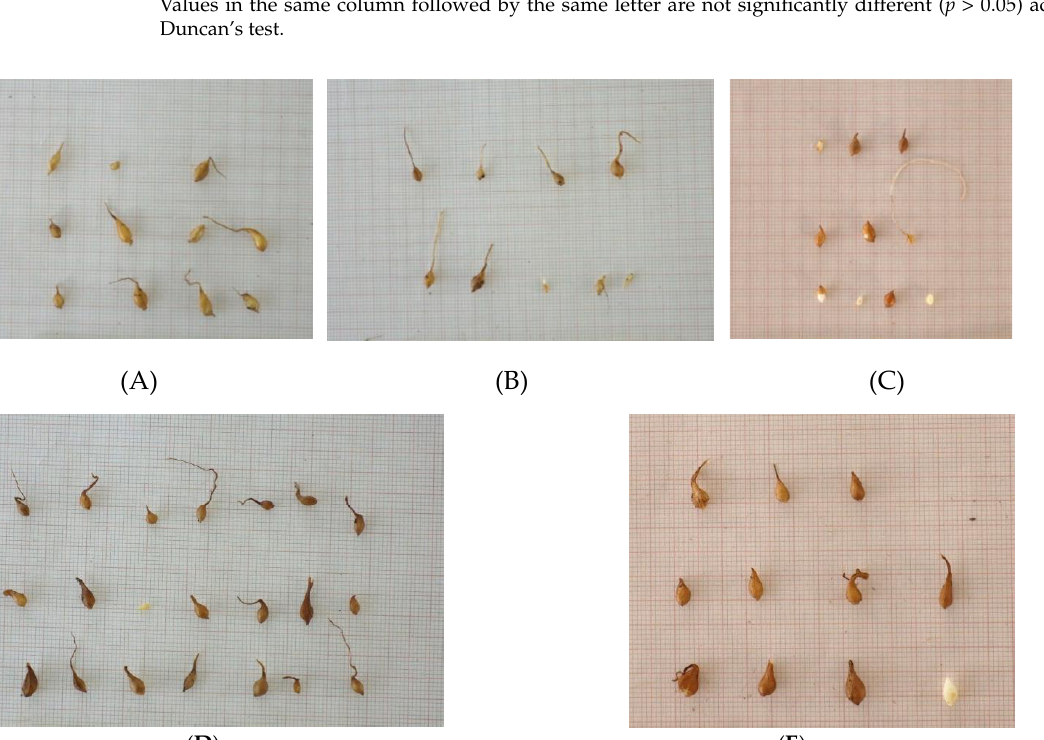
Table 1. Weight, length, and width of Tulipa australis , T. bakeri , T. clusiana , T. goulimyi , and T. un- dulatifolia bulblets at the end of the first growing period. Mean ± standard deviation values are provided. Bulblet Weight Bulblet Length Bulblet Width Species (mg) (cm) (cm) Tulipa australis 25.26 ± 3.76 a 0.2455 ± 0.021 a 0.4909 ± 0.045 ab Tulipa bakeri 11.82 ± 2.50 b 0.1667 ± 0.022 b 0.4333 ± 0.028 bc Tulipa clusiana 15.19 ± 2.31 b 0.1909 ± 0.021 b 0.3545 ± 0.031 d Tulipa goulimyi 14.04 ± 1.72 b 0.1947 ± 0.009 b 0.3842 ± 0.016 cd Tulipa undulatifolia 23.76 ± 2.70 a 0.2583 ± 0.019 a 0.5083 ± 0.023 a Values in the same column followed by the same letter are not significantly different ( p > 0.05) according to Duncan’s test.